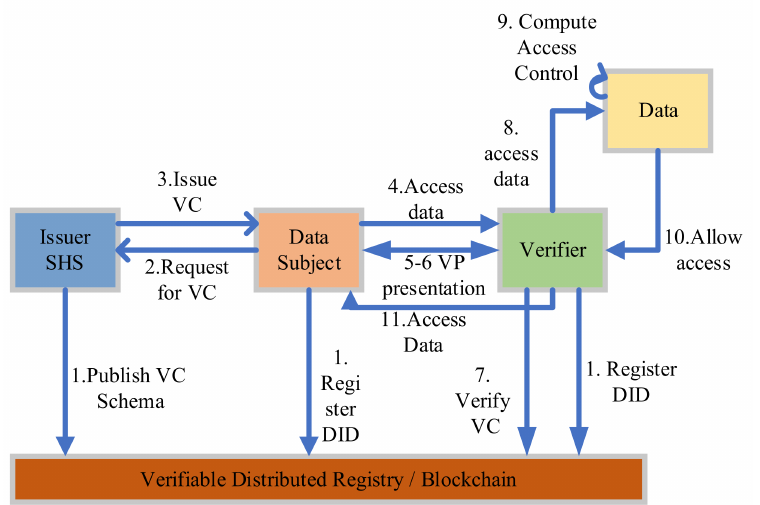
Figure 2. SSI communication Sequence.